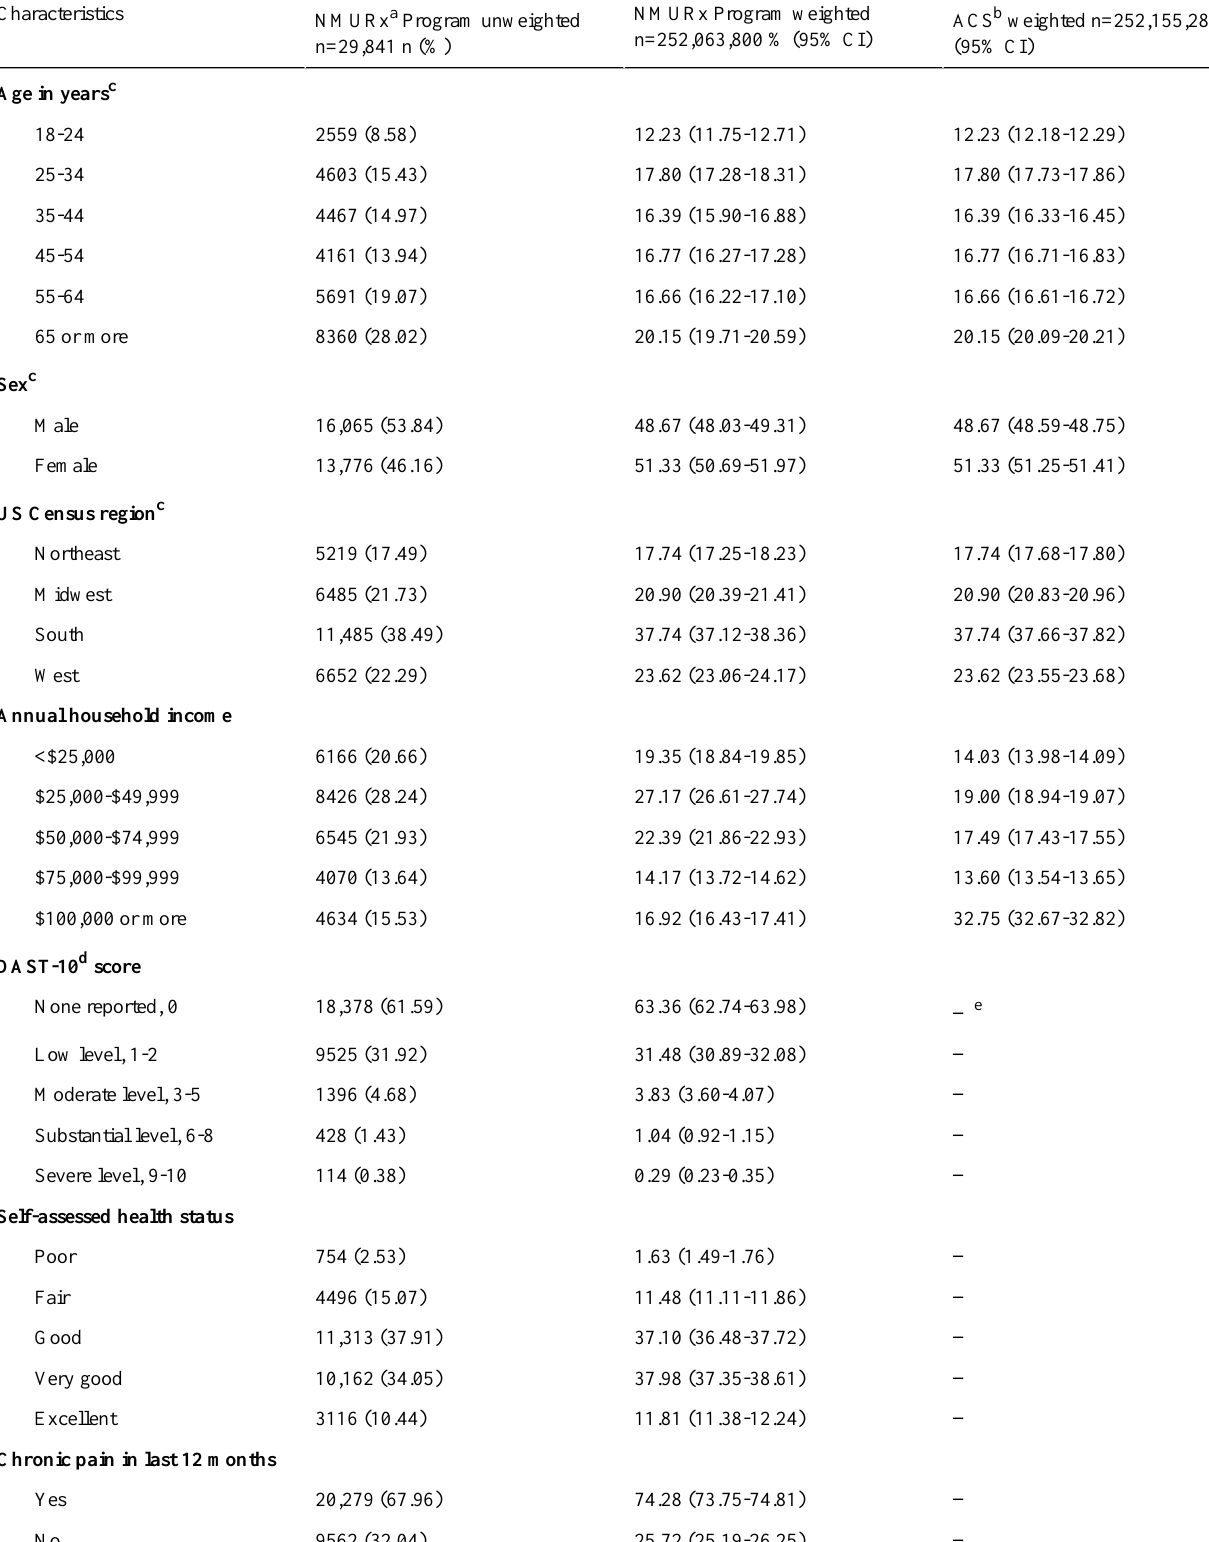
Table 4. Characteristics and national estimates before and after